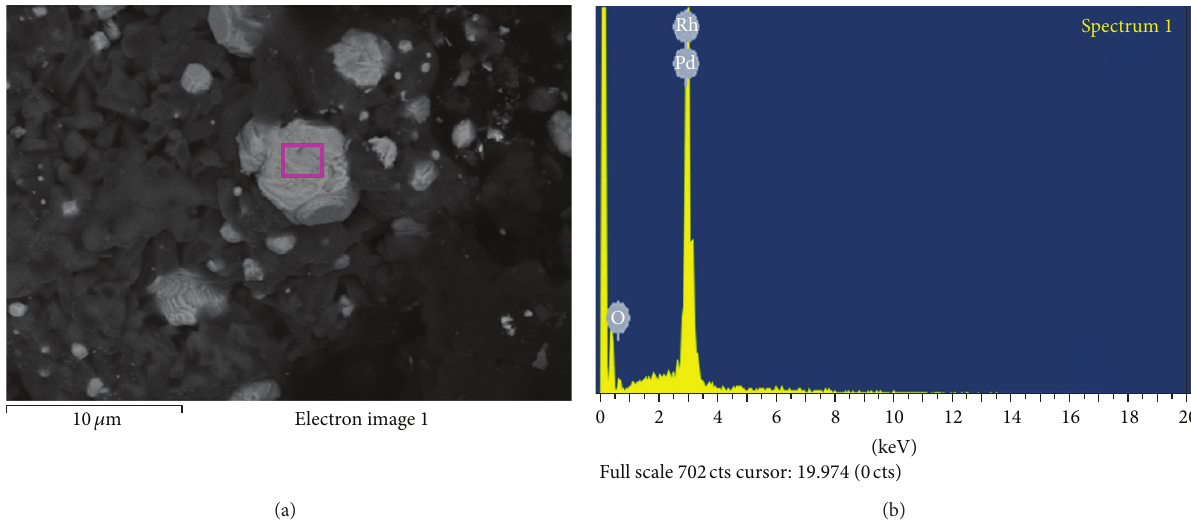
Figure 4: EDS analysis for the Rh-Pd alloy particles after applying the heat treatment at 1000 ∘ C for 2h.